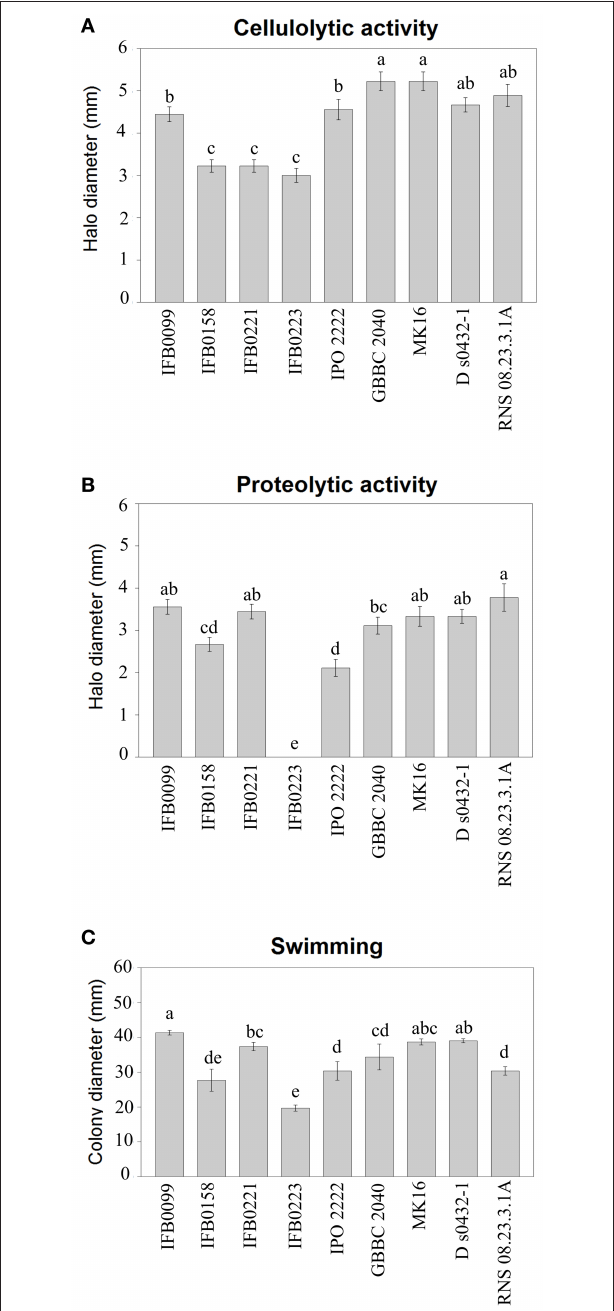
FIGURE 3 | Phenotypic characterization of D. solani strains. (A) Cellulase production was estimated by the diameter (mm) of the haloes observed on the detection plates. (B) Protease production was estimated by the diameter (mm) of the haloes observed on the detection plates. (C) Motility was estimated by the diameter (mm) of the spread of the colonies in the low amount of agar (3g l − 1 ) medium. All the experiments were performed three times. Means ± standard errors are depicted, n = 3. Within each panel, mean values marked with different letters are significantly different by Kruskal–Wallis test followed by post hoc analysis using Fisher’s least significant difference criterion (R agricolae package). All statistical hypotheses were tested at p <